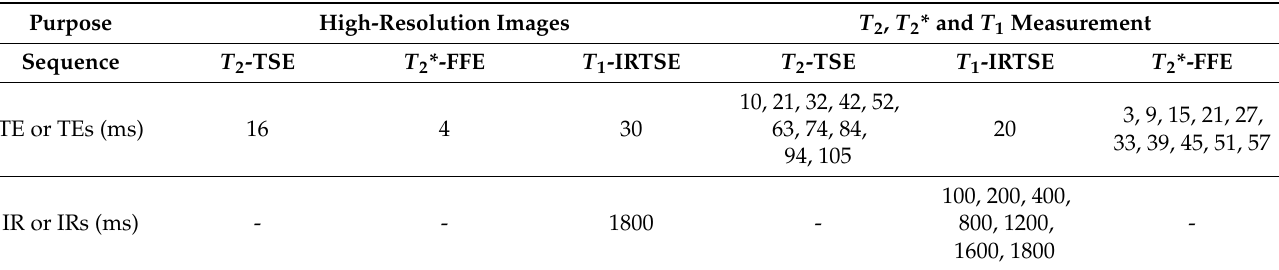
Table 2. Acquisition protocols used for the 16 modern water-soaked